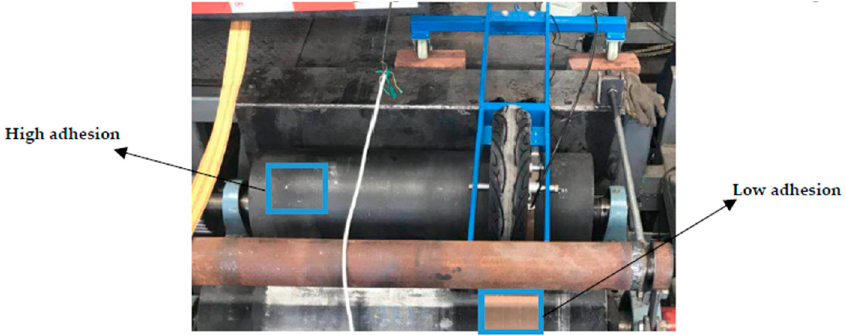
Figure 16. Adhesion coe ffi cient test. Figure 16 . Adhesion coefficient test. Figure 16 . Adhesion coefficient test.